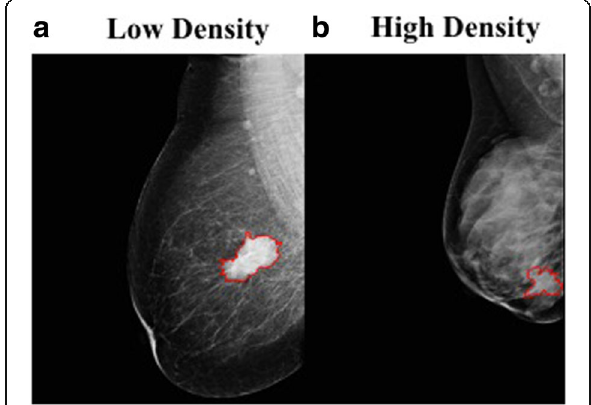
Fig. 1 Exemplars of target-present images. The red outline depicts the mass (and did not appear in the actual stimuli). a Low-density breast that contains predominately fatty tissue, which is radio- translucent or black/grey. The higher contrast mass is easily seen. b High-density breast that contains normal fibroglandular tissue resulting in a more difficult search. The X-ray beam is attenuated by this tissue and appears radio-opaque or white on a mammogram